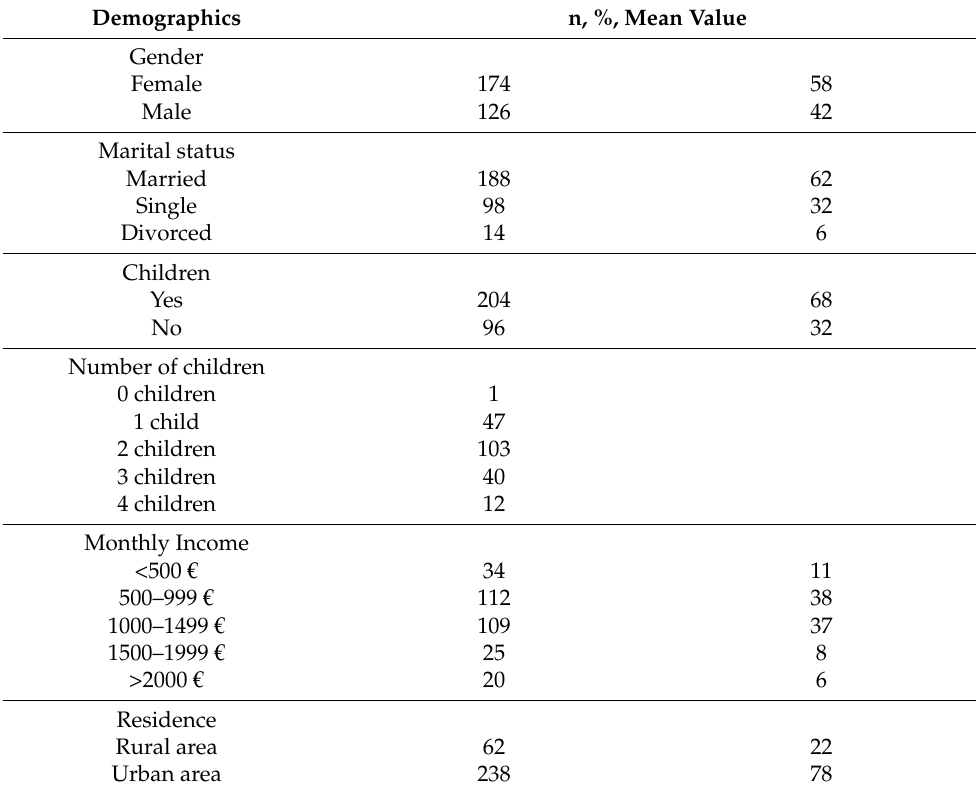
Table 1. Demographic characteristics of the